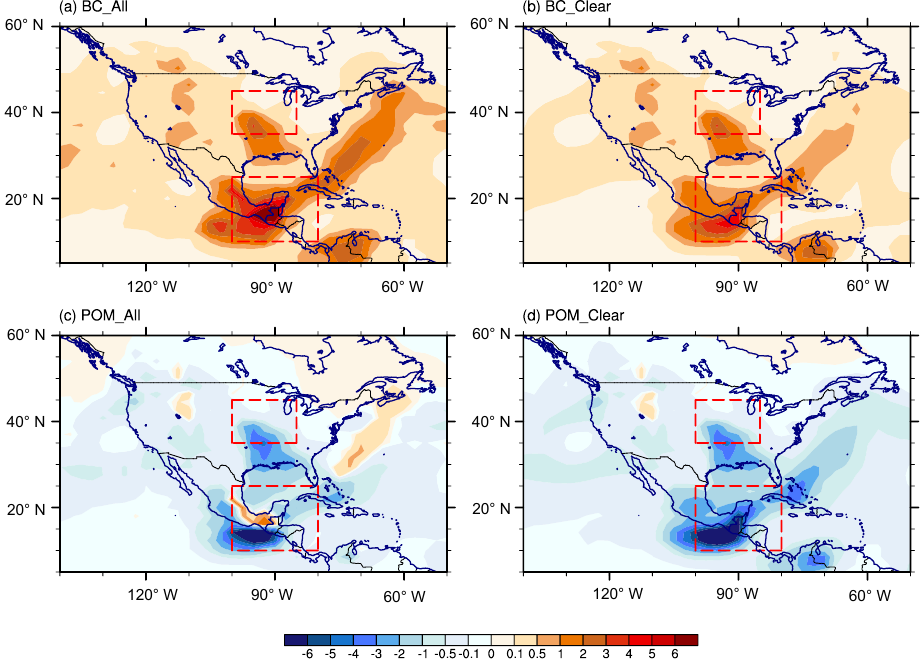
Figure 12. Spatial distributions of fire BC SDRE and fire POM SDRE (Wm − 2 ) under all-sky and clear-sky conditions on 7 April in the E_QF